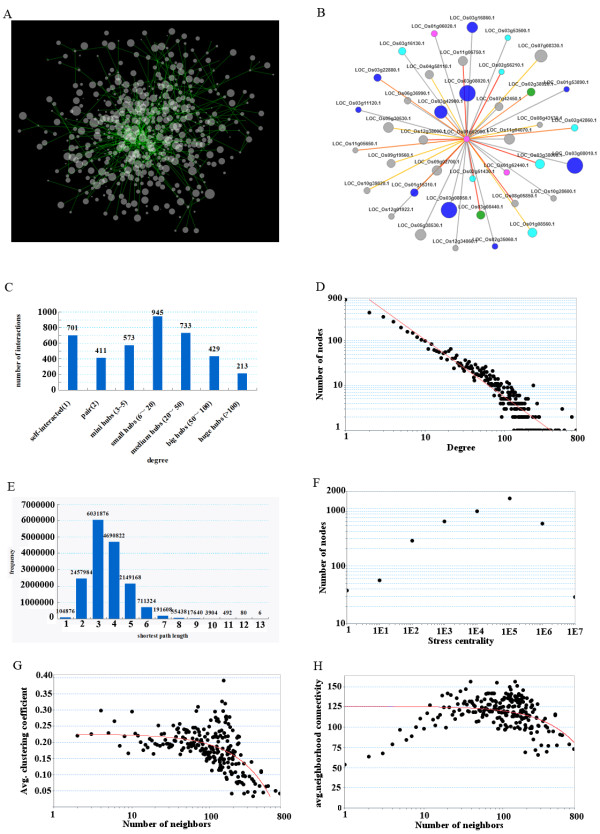
Network visualization and topology. A. Part of the core sub network derived from PRIN, and visualized by Cytoscape. B. Insight view of PRIN. Proteins were mapped to 4 subcellular localization: nucleus (blue), mitochondria (cyan), chloroplast (green) and Cytoplasm (pink). Edge colors correspond to co-expression level, and size of nodes corresponds to node degree. C. 7 kinds of hubs were cataloged in our network, partly reference to Jane etal's study [36]. Apart from self-interacted proteins, proteins in PRIN mainly fall into mini hubs, small hubs and medium hubs. D. The shortest path length of PRIN has an aggregation between 2 and 4, showing significant small world properties. E. The node degree distribution of our network shows the scale-free network topological property. F. The high clustering coefficient value indicates that rice protein-protein interaction is highly modular. G. The stress centrality distribution of PRIN implies a strong fault tolerance. H. The first increased followed by a decrease trend in the neighborhood connectivity distribution suggests that it is more prevail that proteins in high degrees interact with low degree proteins in PRIN.